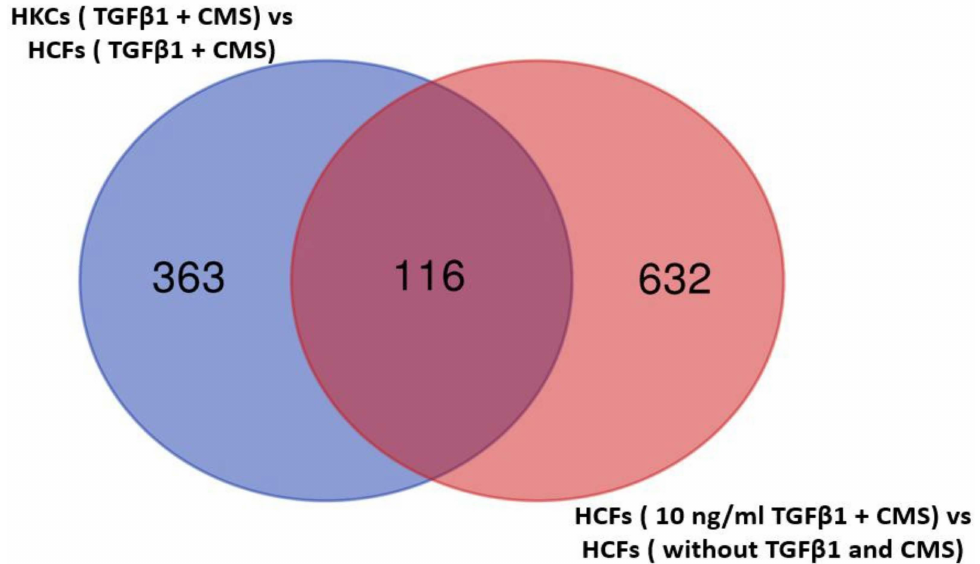
Figure 2. Four hundred and seventy-nine genes that are differentially expressed in HKCs (TGF β 1 + CMS) vs. HCFs (TGF β 1 + CMS) (FDR value ≤ 0.1, fold change ≥ 1.5, and CPM ≥ 10 in at least one sample) are labeled in BLUE. 748 DE genes in HCFs with and without 10 ng/mL TGF β 1 treatment and CMS (FDR value ≤ 0.1, fold change ≥ 1.5, and CPM ≥ 10 in at least one sample) are labeled in LIGHT RED; 116 represent overlapping DE genes in treated HCFs that were also differentially expressed in HKCs (TGF β 1 + CMS) vs. HCFs (TGF β 1 + CMS) (FDR value ≤ 0.1, fold change ≥ 1.5, and CPM ≥ 10 in at least one sample). Table 2. Top 6 upregulated and 10 downregulated overlapping DE genes in HKCs (TGF β 1 +